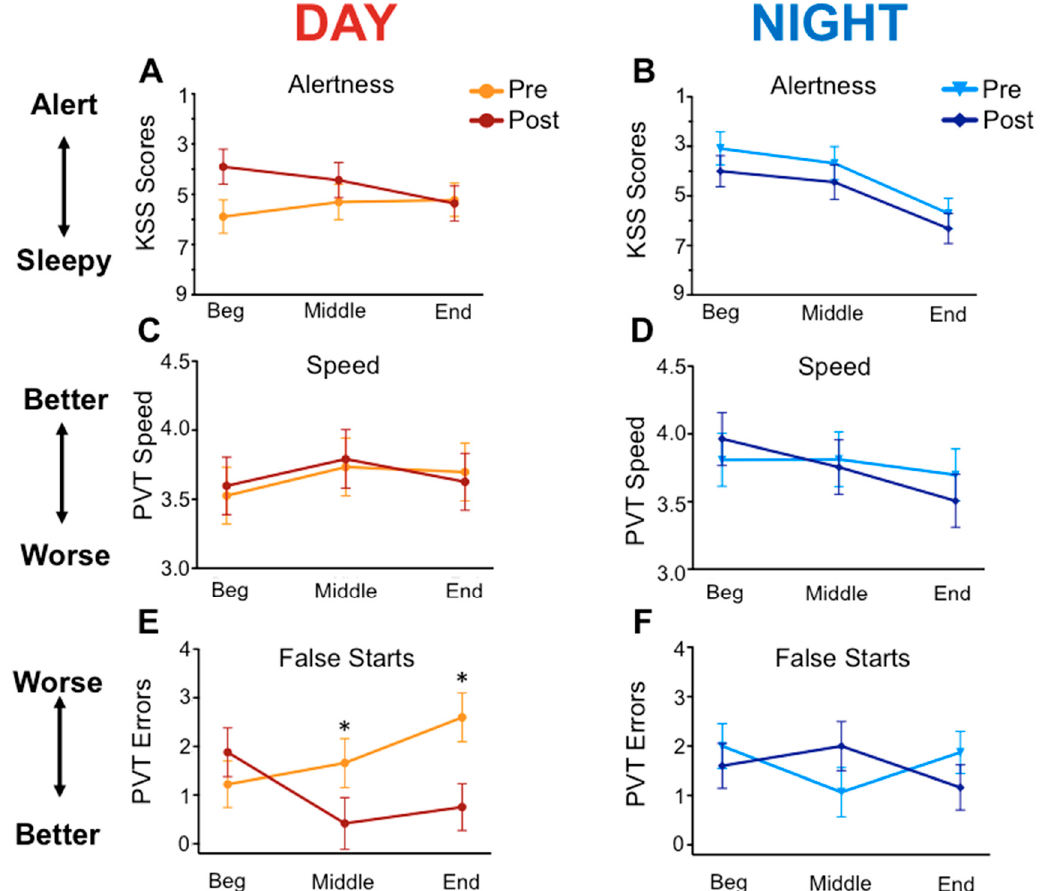
Figure 2. Self-reported sleepiness (KSS) and performance (PVT) on shift from day and night workers pre- and post-intervention. Participants were prompted via text at the beginning, middle, and end of one work day in each condition to report sleepiness on a scale of 1–9 (Karolinska Sleepiness Scale; KSS) and to complete a validated, 3 min tablet-based version of the PVT [11]; Pulsar Informatics, Philadelphia, PA, USA). Panels ( A ) and ( B ) are KSS scores across shift for day and night workers, respectively. Panels ( C ) and ( D ) are PVT speed, and ( E ) and ( F ) are PVT False Starts. Asterisks denote p <